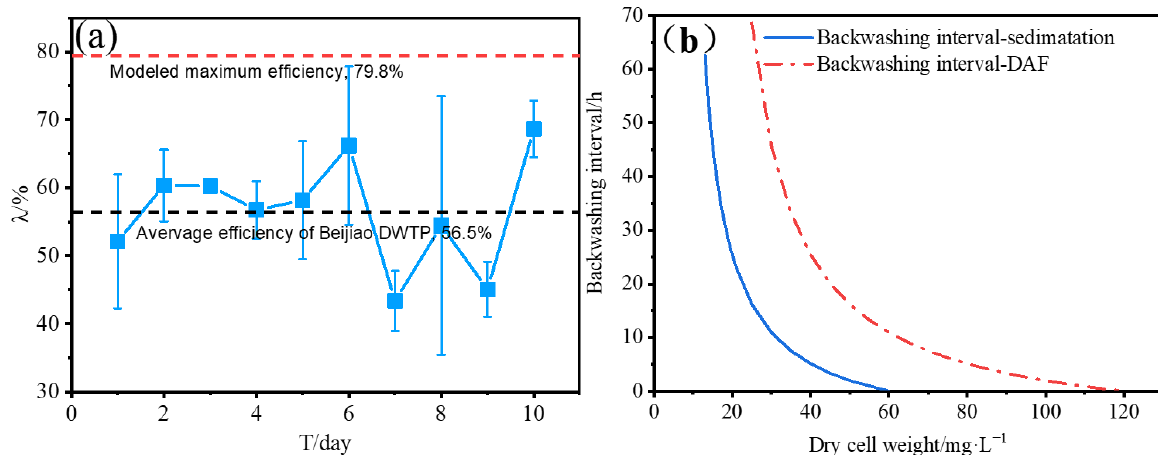
Figure 4. ( a ) Modeled maximum sand filtration sufficiency and actual sand filtration efficiency obtained by sampling 1 backwash interval (24 h) in the Beijiao DWTP, ( b ) changes in the backwash interval with differing algae concentrations in raw water under a sand filter effluent water concentration of 1.2 mg ∙ L − 1 .